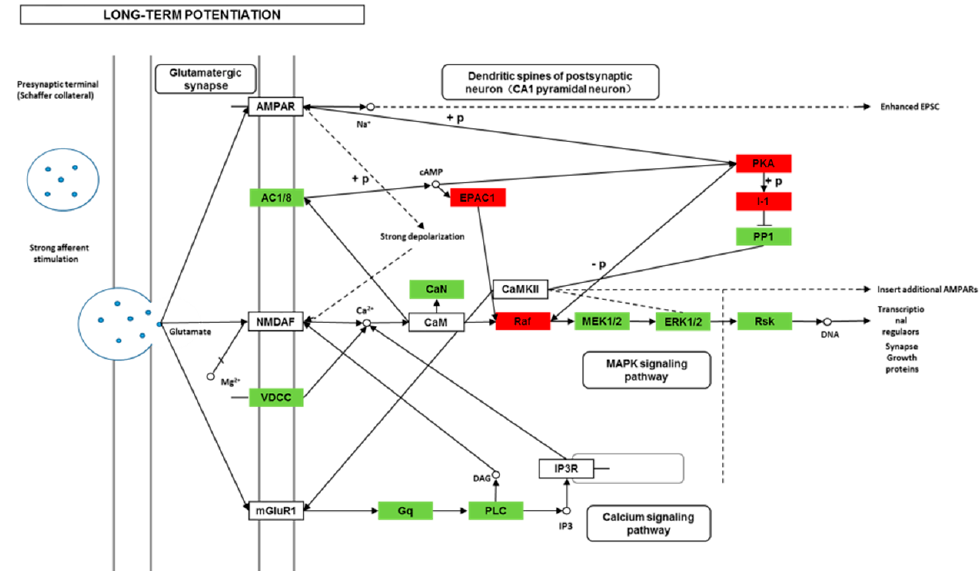
Figure 6. Differentially expressed genes in the long-term potentiation between mandarin fish in the control group (CG) and the learning group (LG) from a transcriptome analysis. The colors of rectangles were shaded according to the different expression (red: The mRNA expression levels of fish in Group LG were significantly higher than those in Group CG (FDR ≤ 0.001, the absolute value of log2 (Ratio) ≥ 1); green: The mRNA expression levels of fish in Group LG were significantly lower than those in Group CG (FDR ≤ 0.001, the absolute value of log2 (Ratio) ≥ 1)).